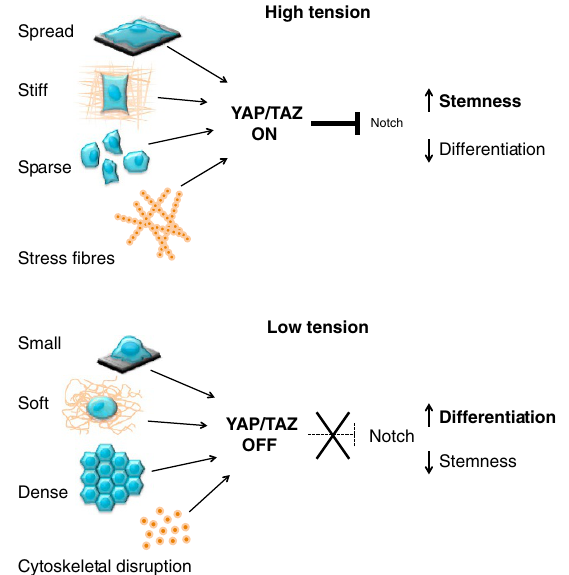
Figure 8 | Cell mechanics drives differentiation and stemness in epidermal SCs through YAP/TAZ. See Discussion section for